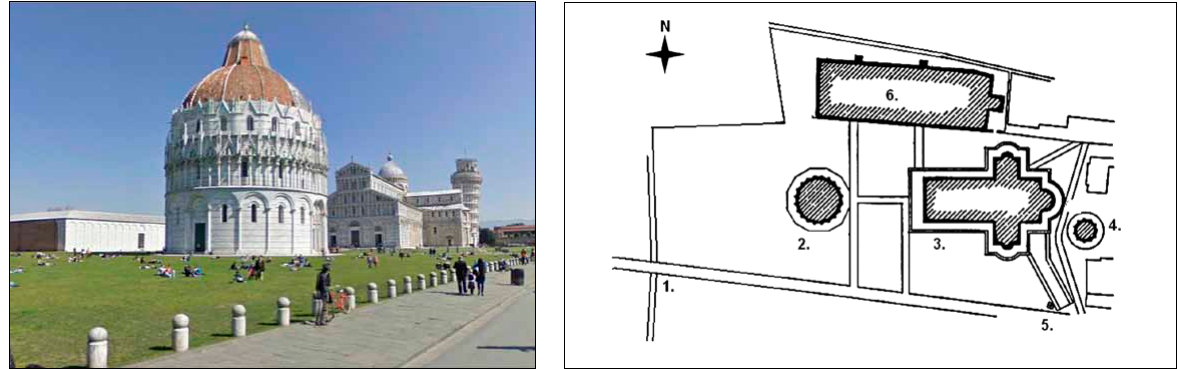
fig. 3. Piazza dei Miracoli ensemble in Pisa: as seen from the entrance and in plan: 1) the entrance to churchyard; 2) the baptistery; 3) the cathedral; 4) the bell tower; 5) the fountain; 6) the cemetery building. Sources : https://maps.google.lt/ maps?output=classic&dg=brw;